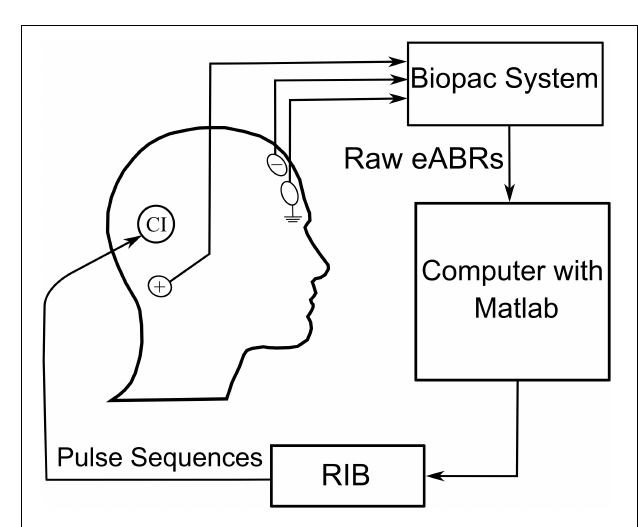
FIGURE 2 | Setup for electrical stimulation via CI and eABR recording.